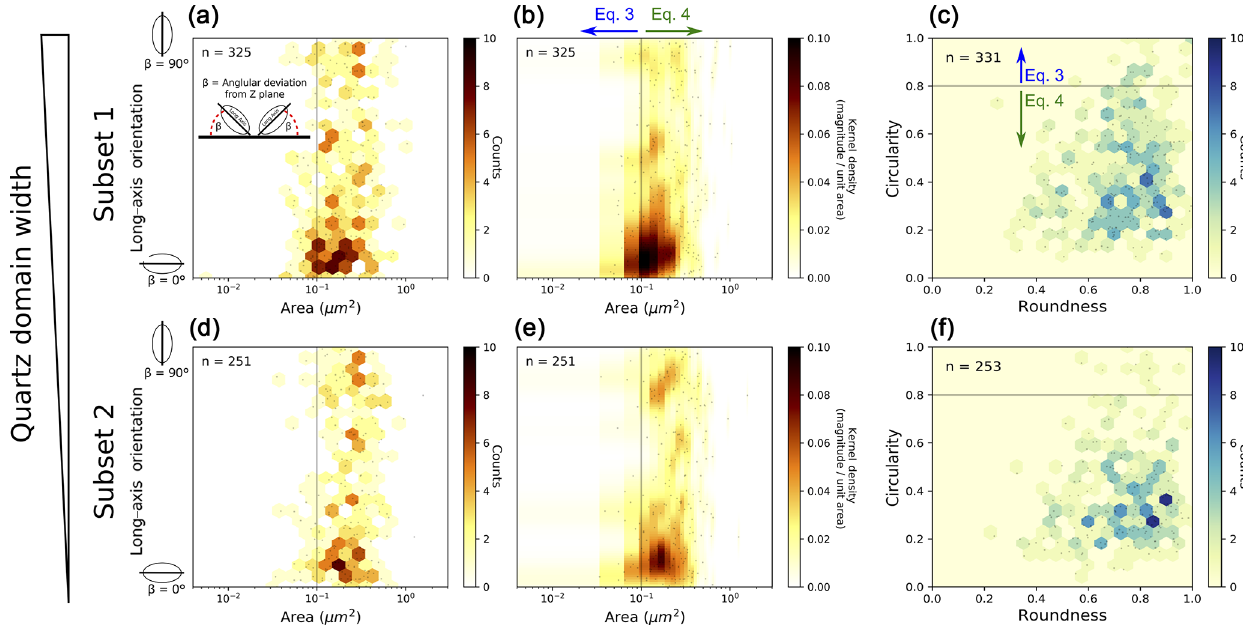
Figure 5. Pore analyses for subsets 1 and 2 shown in Fig. 1b corresponding to decreasing quartz domain width and increasing quartz dispersion. Lines marking the change in pore shape relations described by Eqs. (3) and (4) are presented in each plot. Panels (a, d) present pore long-axis orientation against pore area data in hexbin plots, while panels (b) and (e) show the same data but with true point density analysis. Both sets of figures show that with decreasing quartz band thickness, there is an increase in the range of pore orientations observed. Panels (c) and (f) demonstrate that this change is also concordant with a change in the pore shapes from roughly elliptical to more complex. More specifically, it can be seen in panels (b) and (d) that with decreasing domain width there is a loss of circular and elliptical